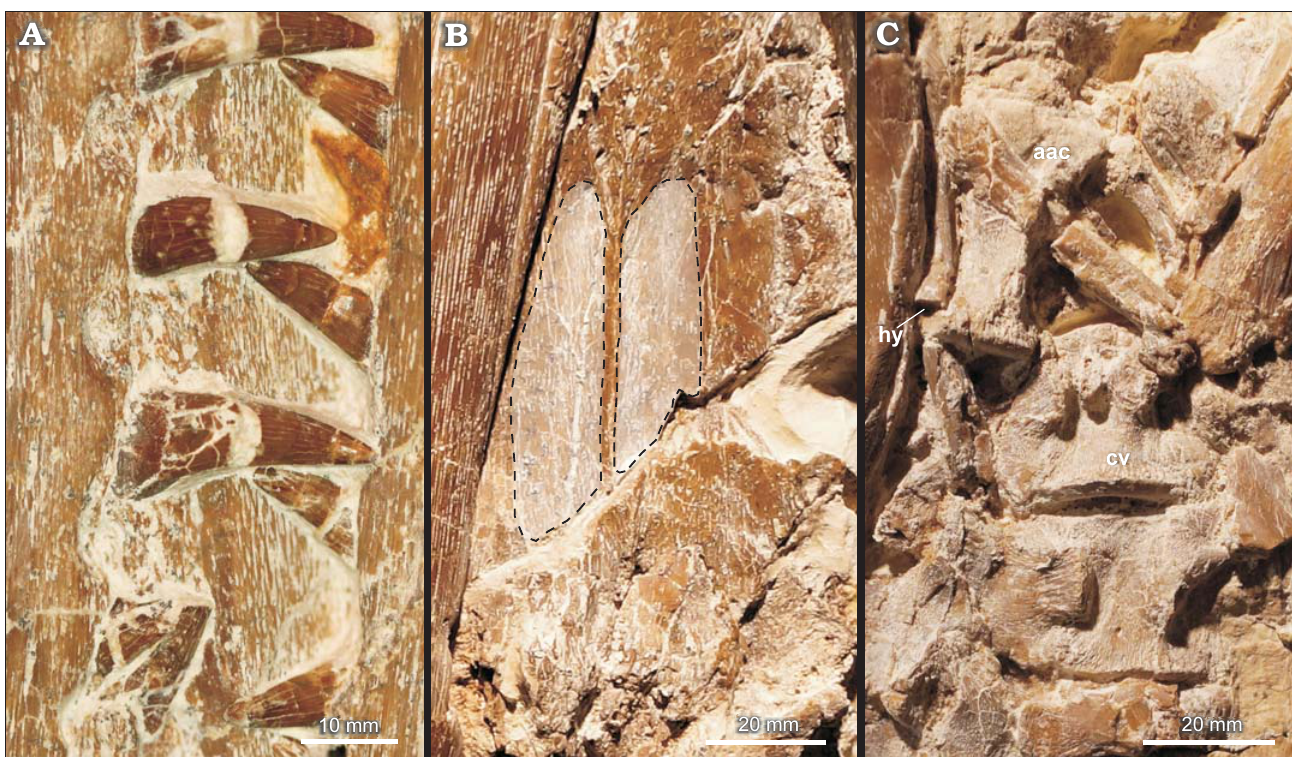
Fig. 4. Metriorhynchid thalattosuchian Cricosaurus bambergensis sp. nov. (NKMB-P-Watt14/274) holotype, late Kimmeridgian of Wattendorf (south- ern Germany). A . Dentition. B . Pala tines showing the midline keel seperating symmetrical depressions (dashed outline). C . First cervical vertebrae. Abbreviations: aac, atlas-axis vertebrae; cv, cervical vertebra; hy,